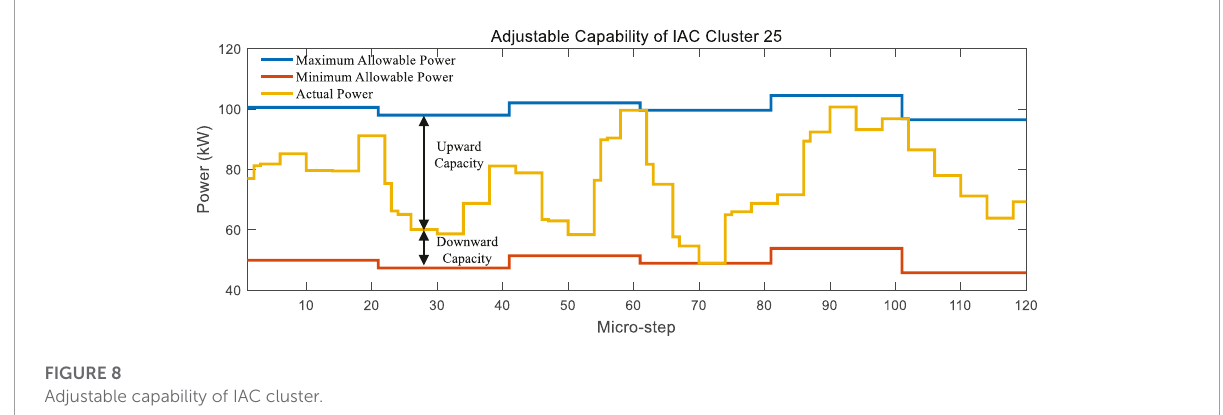
FIGURE 8 Adjustable capability of IAC